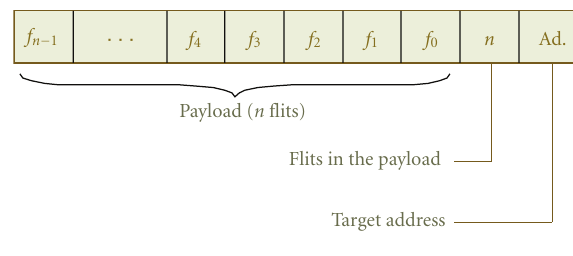
Figure 5: Packet